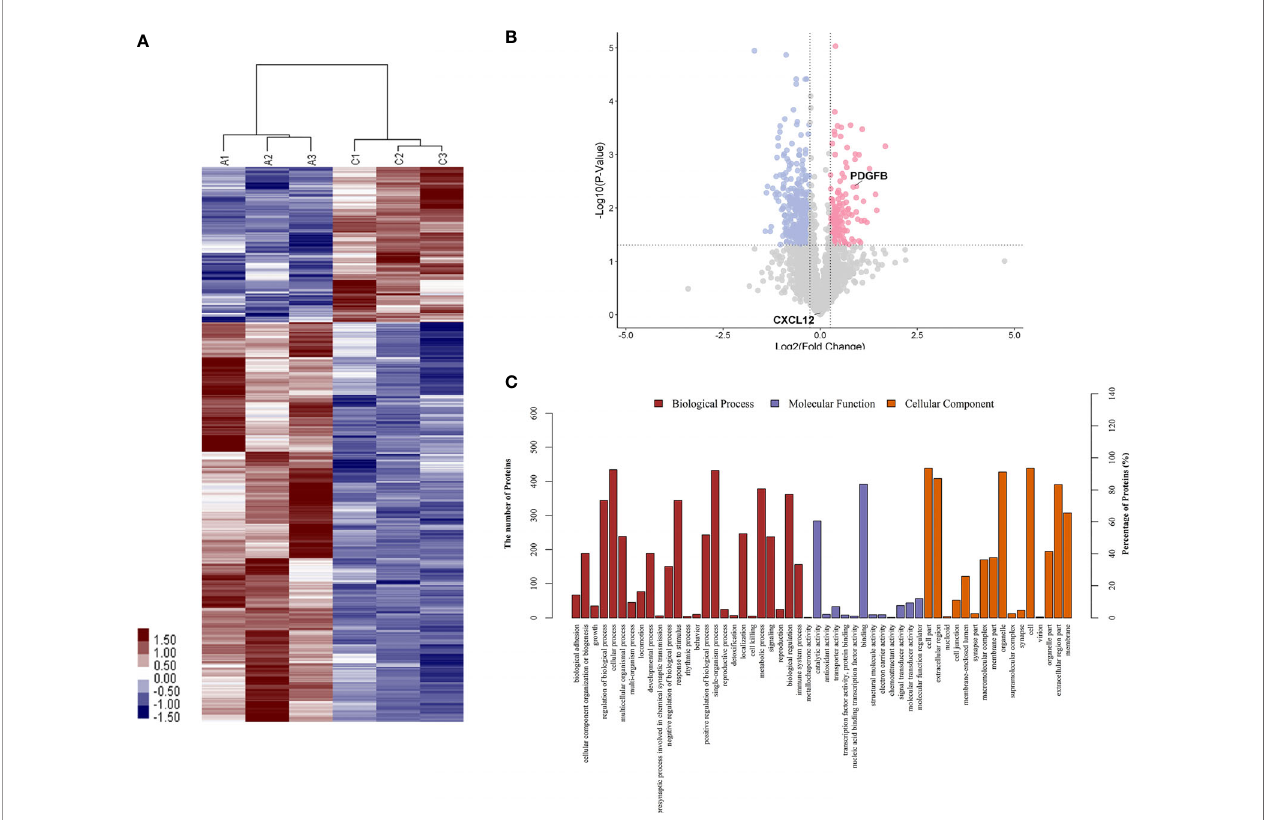
FIGURE 2 | The differentiated urine proteins between patients with OAPS and HCs analyzed by iTRAQ study. (A) Cluster analysis of patients with OAPS with HCs (A represented HCs; C represented OAPS). (B) Volcano plot showed that PDGFB was in the upper right quadrant, which was in pink color area. (C) Gene ontology (GO) analysis of OAPS vs HCs. iTRAQ, isobaric tags for relative and absolute quanti fi cation; OAPS, obstetric antiphospholipid syndrome; HCs, healthy